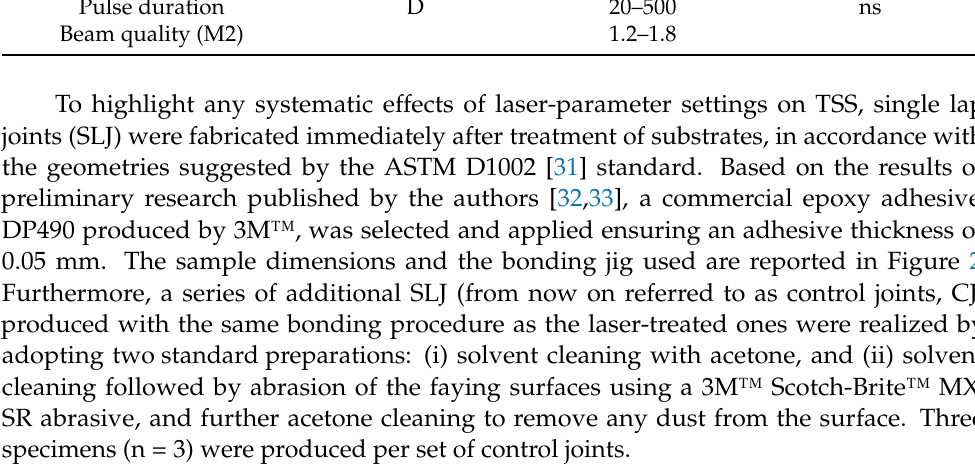
Figure 1. Schematic description of the geometric control factor.